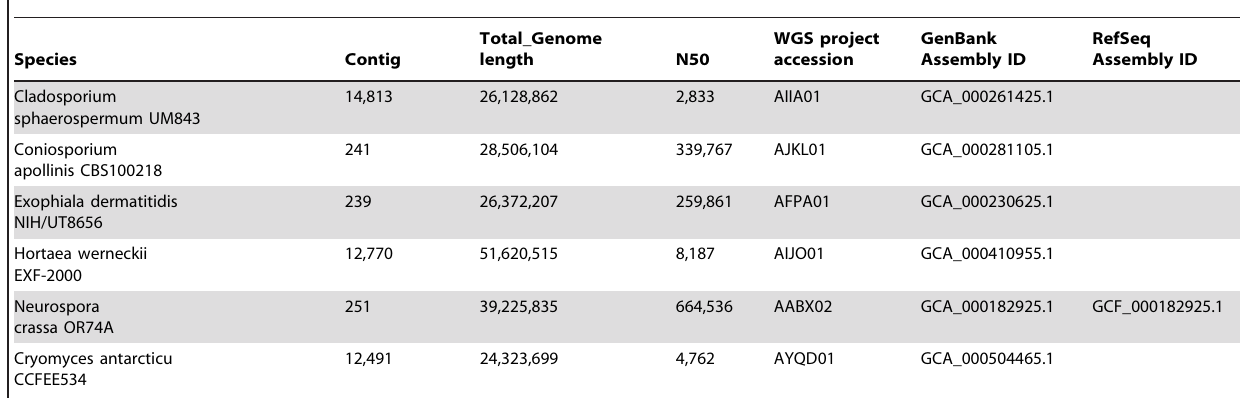
Table 1. Genome Assembly